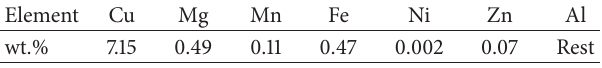
Table 1: Chemical composition of aluminum alloy.